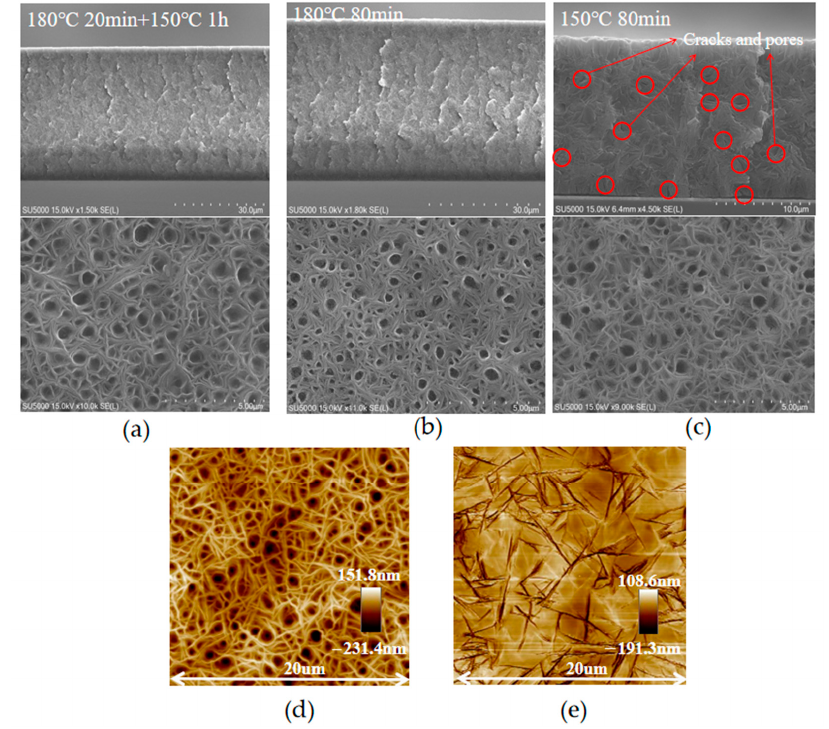
Figure 3. Cross-section and surface images of P(VDF-TrFE) film: ( a ) annealing temperature reaches above the melting point (sample S1); ( b ) annealing temperature always above the melting point (sample S2); ( c ) annealing temperature consistently below the melting point (sample S3), red circles mark the cracks and pores; ( d ) AFM image of the surface before etching treatment; ( e ) AFM image of the surface after etching treatment.